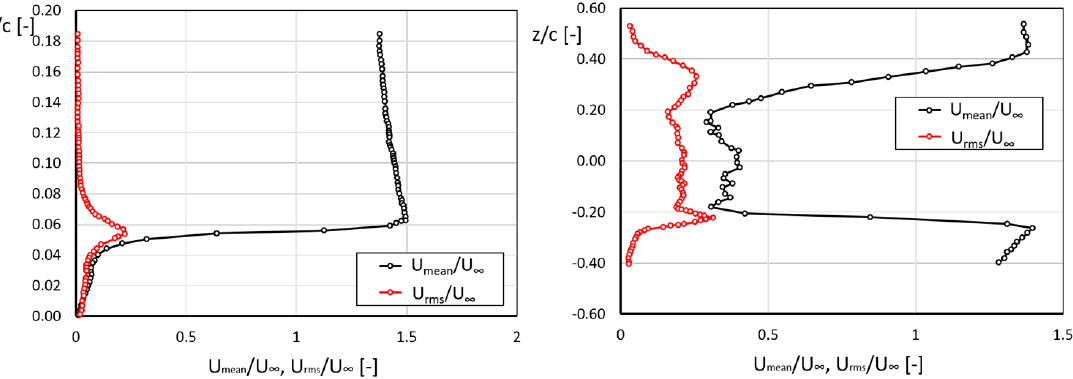
Figure 6. Example of the location where the PSD analysis took place for: the shear layer region close to the leading edge (lines L1, L2, and L3) ( left ); and the region of wake (W1 and W2) as depicted in Figure 5 ( right ).